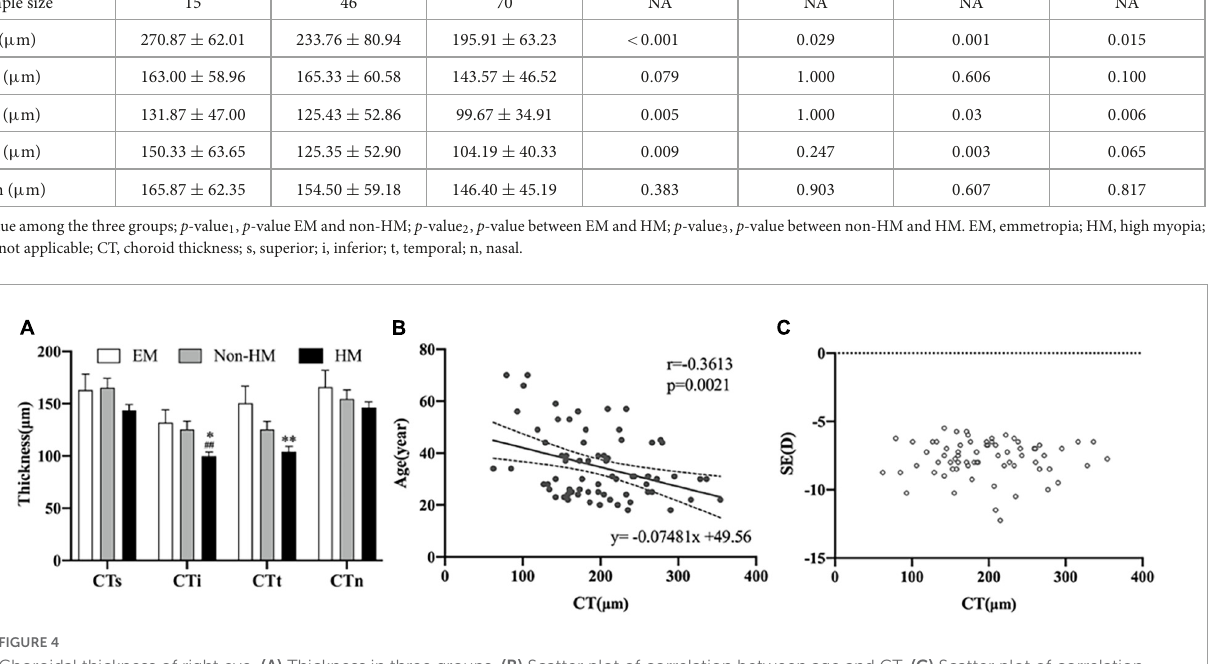
as the means ± SEM. Comparisons between groups were performed using independent t test, one-way ANOVA, Welch, and Brown-Forsythe test followed by Bonferroni and Tamhini multiple comparison tests. A p -value < 0.05 was considered statistically significant.